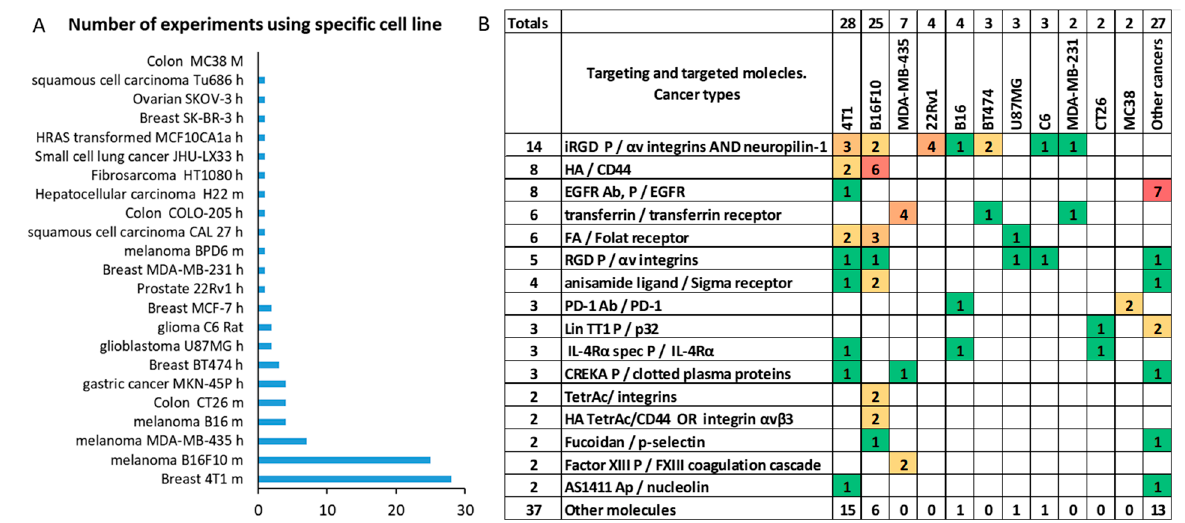
Figure 6. Dataset characteristics. ( A ) Number of experiments performed using different cell lines from either human or mouse; ( B ) Number of experiments for the top 16 most frequently annotated targeting molecules together with targeted molecules and cancers. The number of extracted datasets is highlighted by coloring. The remaining 37 targeting and targeted molecule combinations were tested only once. Here, P stands for peptide, Ac is acid, Lig is a ligand, Ab is an antibody, Ap is an aptamer.